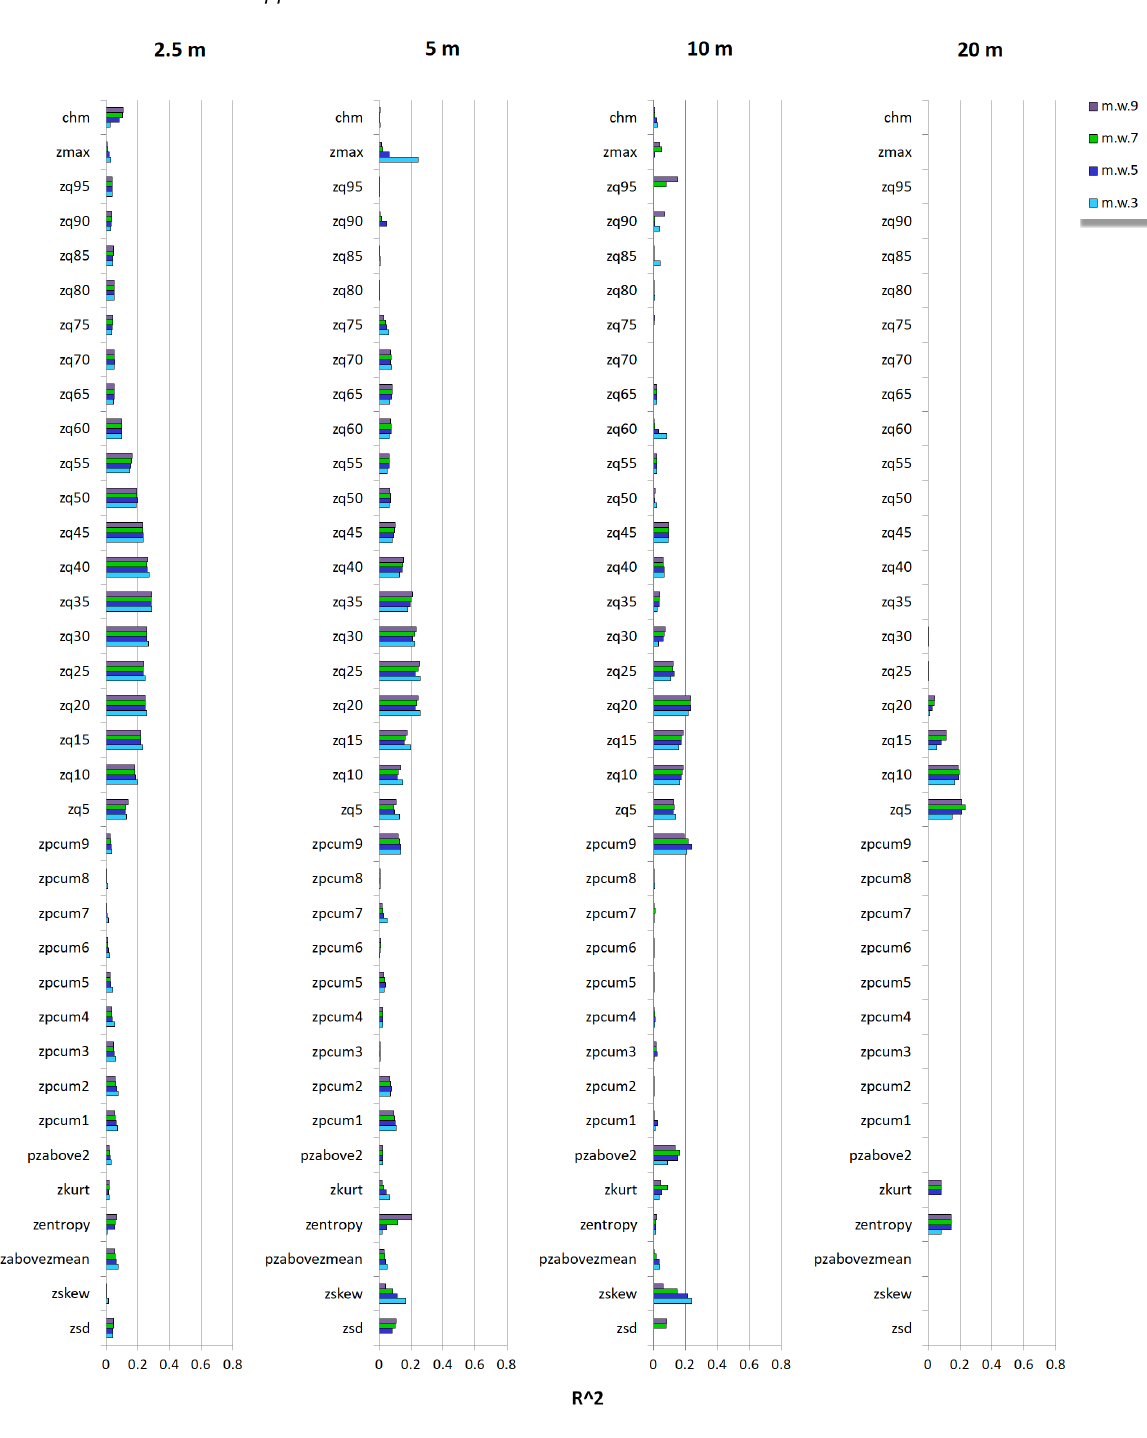
Figure A4. Histograms concerning the R 2 values relative to the linear regression between Shannon’s H field index and the mean of the CRE matrices of each LiDAR metric and for each MW (San Genesio/Jenesien study